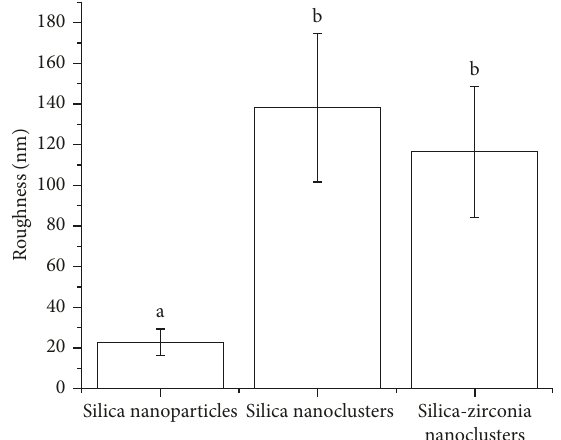
Figure 8: Roughness of materials reinforced with 30% by weight of particles. The letters indicate statistically homogenous groups (Tukey HSD test ( p > 0 . 05)).